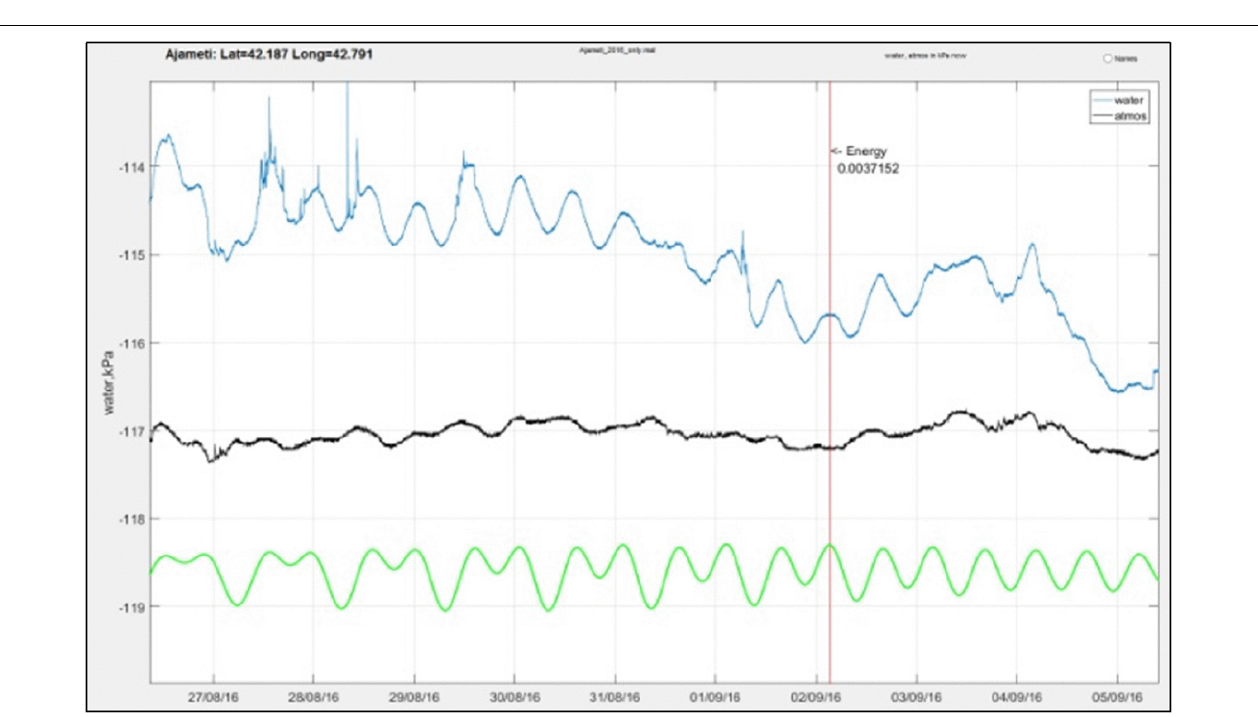
Frontiers in Earth Science |